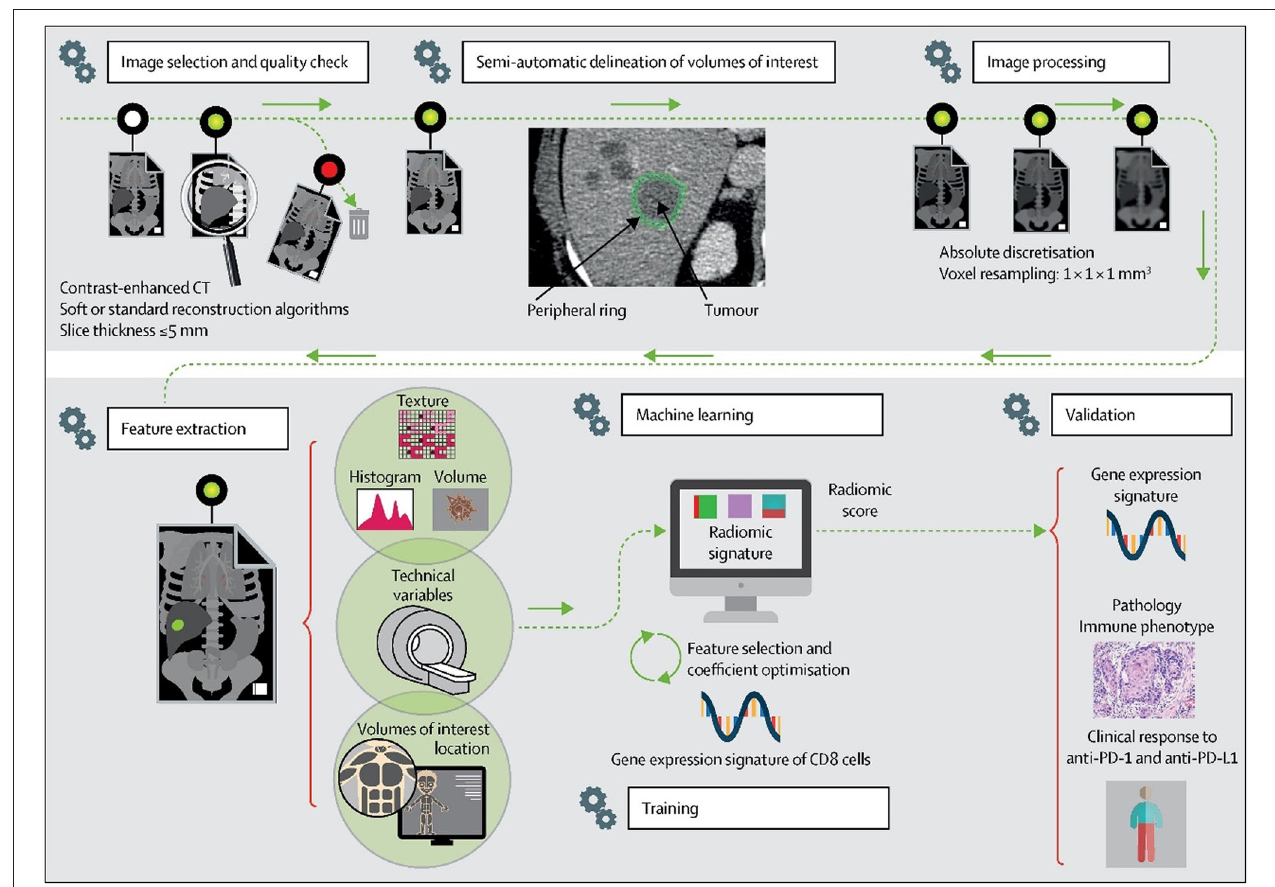
FIGURE 6 | Radiomics